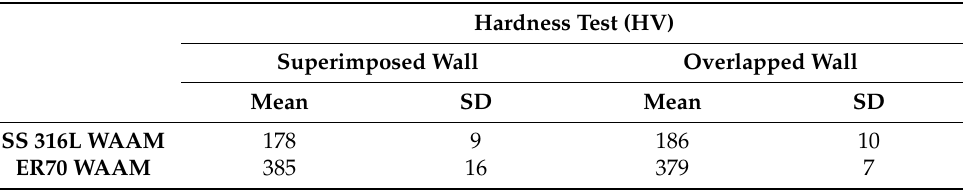
Table 5. Summary comparison of hardness characterization on SS 316L side and ER70 side on walls fabricated under different